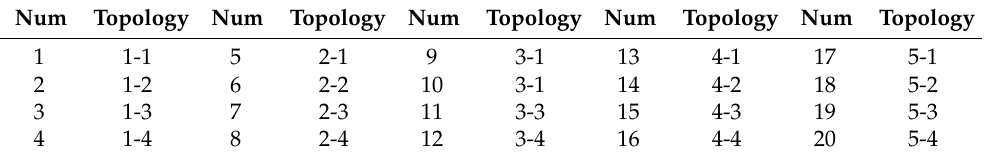
Table 6. The initialization parameters used in the ABC